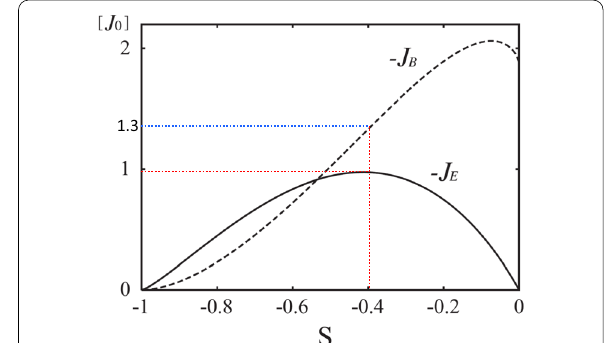
Fig. 3 Resonant currents as function os S . Variation of resonant currents J E in solid line and J B in dashed line as functions of the inhomogeneity factor S . At S J B 1.3 J 0 as indicated by dotted = −